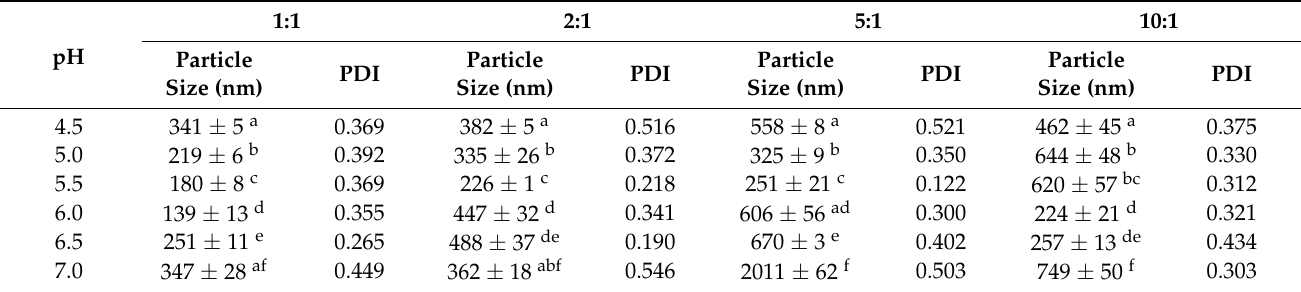
Table 1. Particle size and polymer dispersity index (PDI) of